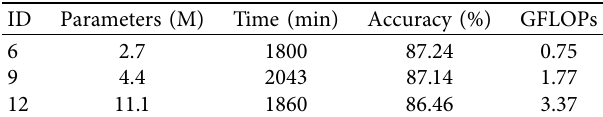
Figure 10: Dual-core compressed activation neural network model. Table 1: Accuracy of DKSE module at IDs 6, 9, and